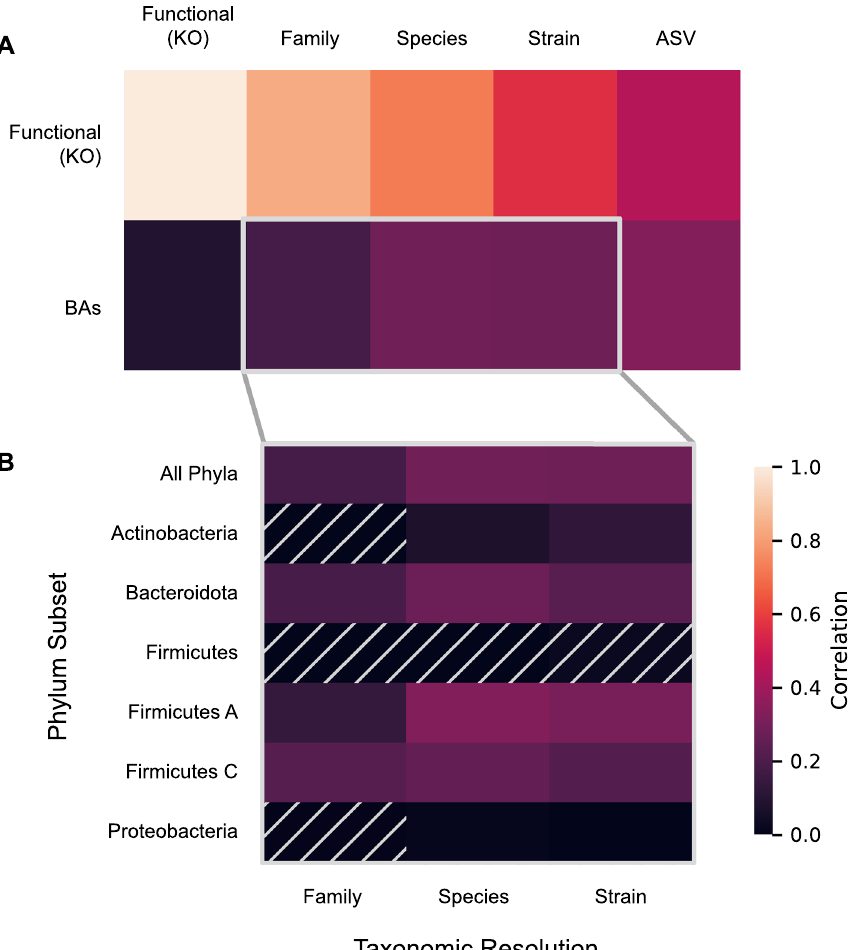
Figure 4. Changes across taxonomic, functional, and BA profiles are correlated. Heatmap tiles depict Pearson correlation coefficients between all within-patient pairwise dissimilarity scores, controlling for time, with brighter colors indicating a stronger association between profiles. Comparisons are for (A) each pairwise comparison between taxonomic and functional gene profiles with BA and functional gene profiles, or (B) BAs, specifically, compared across taxonomic profiles at different resolutions (X-axis) and phylum-level subsets (Y-axis). Hatched cells indicate comparisons where p-values are > 0.05 by Mantel permutation test (n = 9999); all other comparisons are significant at or below this